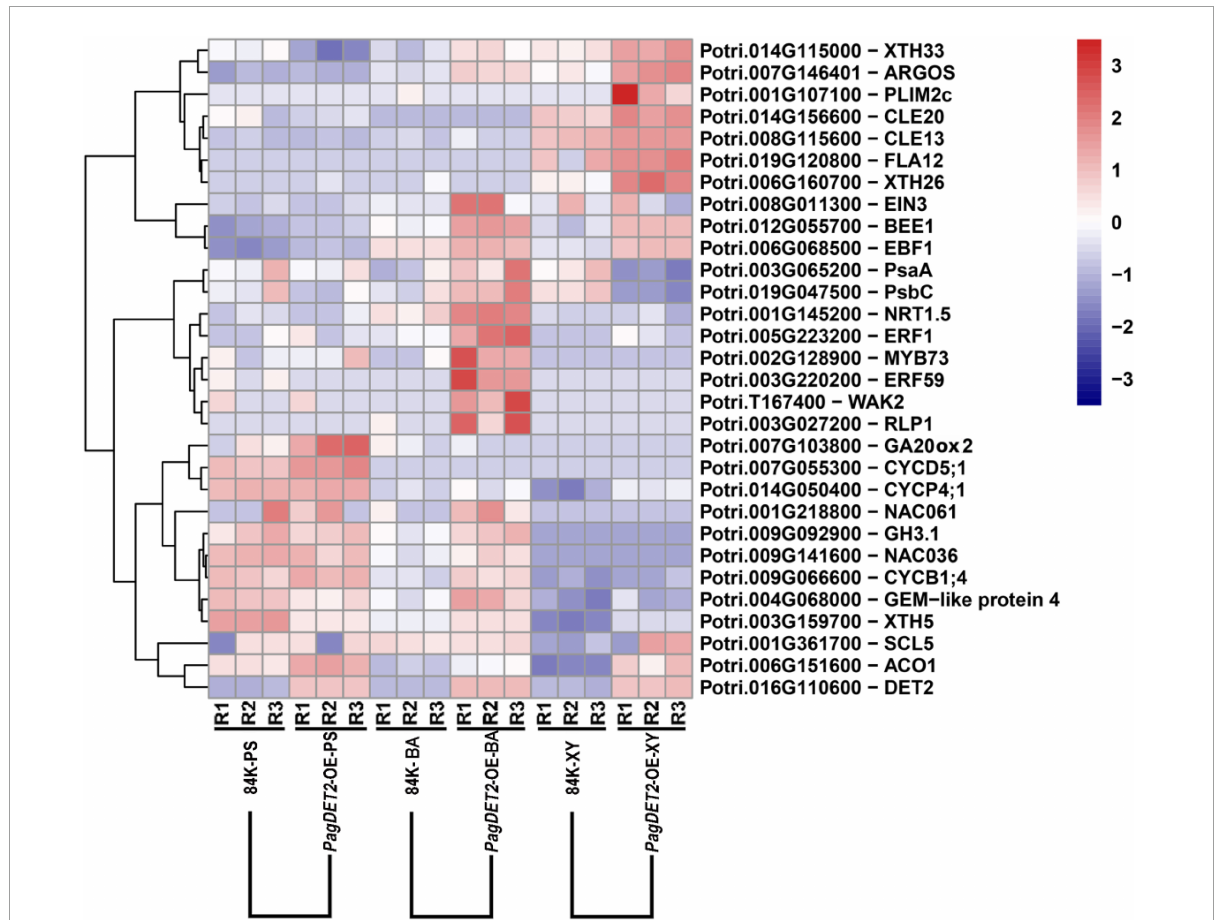
FIGURE6 Representative gene expression in the heatmap. Heatmap shows representative gene expression across all the 18 samples, including cell cycle protein-encoding genes CYCD , CYCB ; cell wall biosynthesis-related genes XTHs ; transcription factor encoding gene ERF1 and ethylene synthase encoding gene ACO1 responding to ethylene